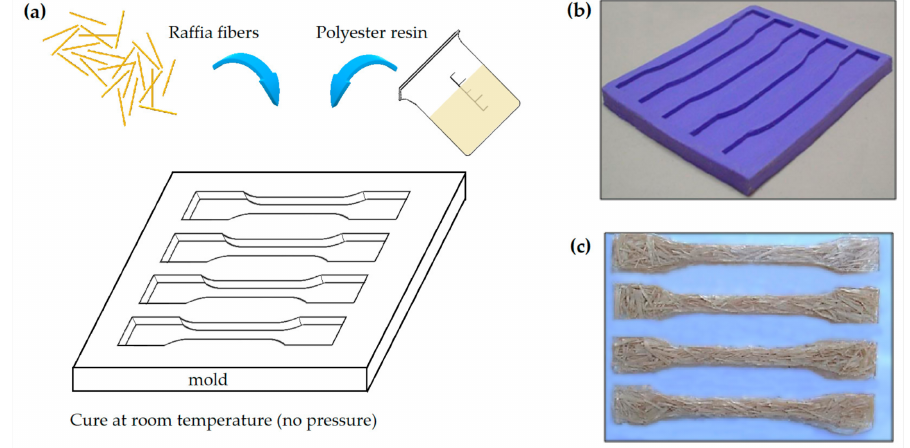
Figure 3. Design and manufacturing of ra ffi a fiber composite: ( a ) process scheme; ( b ) mold; and ( c )